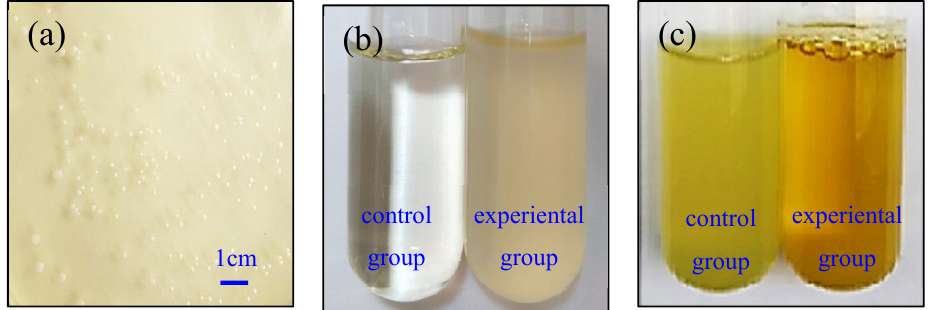
Figure 2. The colony morphology and the ammonia test of the S. epidermidis Y2 strain: ( a ) the colony morphology of S. epidermidis Y2; ( b ) the color before adding Nessler’s reagent; ( c ) the color after adding Nessler’s reagent. Dark yellow or brown shows the ammonia test result is positive. Light yellow shows the color of Nessler’s reagent. The ammonia test shows that ammonia has been released by S. epidermidis Y2 strain.